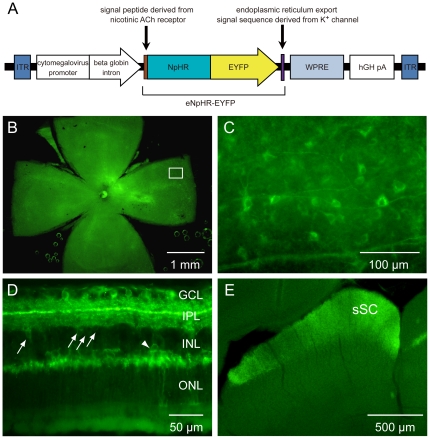
Expression of eNpHR-EYFP in retina and sSC.
A, The AAV-CMV-eNpHR-EYFP-WPRE expression cassette: ITR: inverted terminal repeat; CMV: cytomegalovirus promoter; eNpHR: enhanced halorhodopsin; EYFP: enhanced yellow florescent protein; WPRE: woodchuck post-transcriptional regulatory element; hGH pA: human growth hormone polyadenylation sequence. B,C, eNpHR-EYFP fluorescence images taken from retinal whole-mount at low (B) and high (C) magnification. The rectangular area in B is enlarged in C. D, eNpHR-EYFP fluorescence image taken from retinal vertical section. EYFP-positive ganglion cells and axons were observed in the GCL. Arrows point to infected amacrine cells and an arrowhead points to an infected horizontal cell. E, eNpHR-EYFP fluorescence image taken from the superficial layer of the superior colliculus (sSC) in coronal section. Dense EYFP-positive RGC-derived axons were observed throughout the medio-lateral axis. GCL: ganglion cell layer; INL: inner nuclear layer; IPL: inner plexiform layer; ONL: outer nuclear layer.